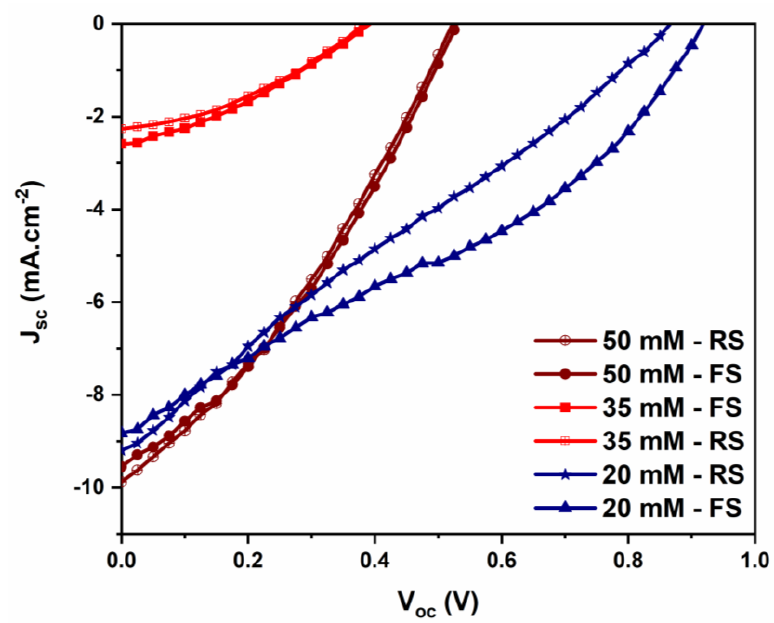
Figure 3. J–V characteristics of perovskite solar cells (best device) fabricated with the photoanodes of ZnO NWs depending on [Zn(NO 3 ) 2 ] concentrations. Table 6. Performance of perovskite solar cells (reverse scan) fabricated with the photoanodes of ZnO NWs depending on the [Zn(NO 3 ) 2 ] concentration ([Zn 2+ ]/[PEI] = 4.5; [Zn 2+ ]/[HMTA] = 1.33, growing time of 6 h).